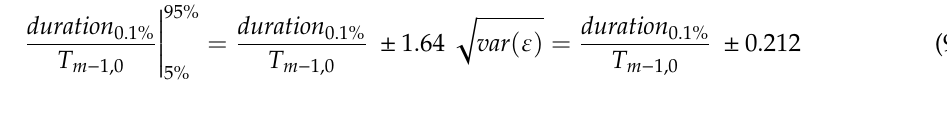
Figure 12. Comparison between the measured and estimated dimensionless duration 0.1% using Equation (7).